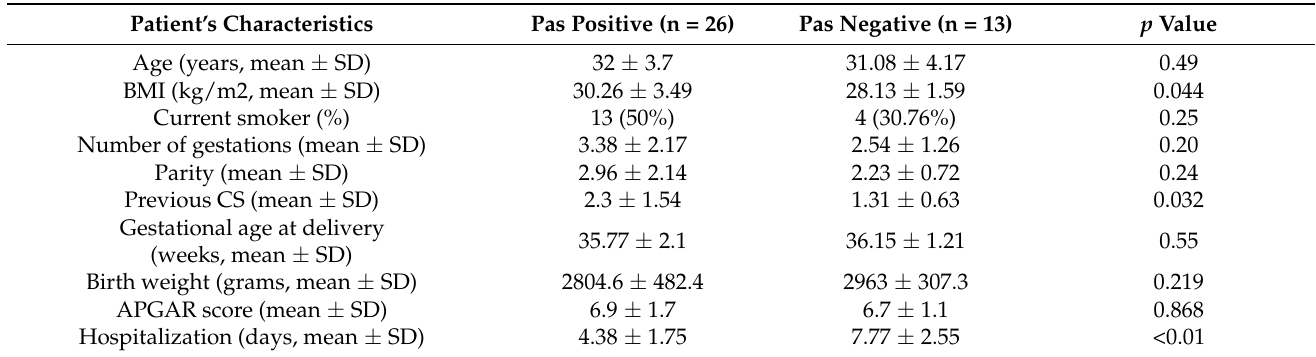
Table 1. Patients’ characteristics and risk factors for PAS segregated between PAS-positive and PAS-negative groups.